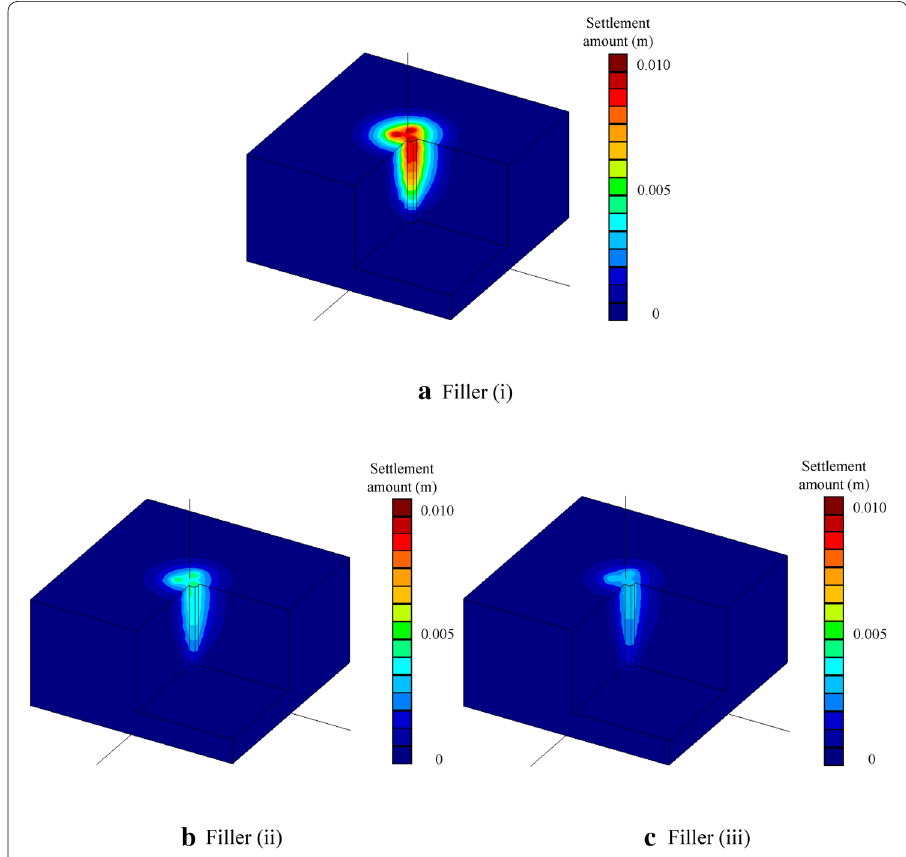
Fig. 6 Settlement of surrounding ground when pullout holes are filled. a Filler (i). b Filler (ii). c Filler (iii)